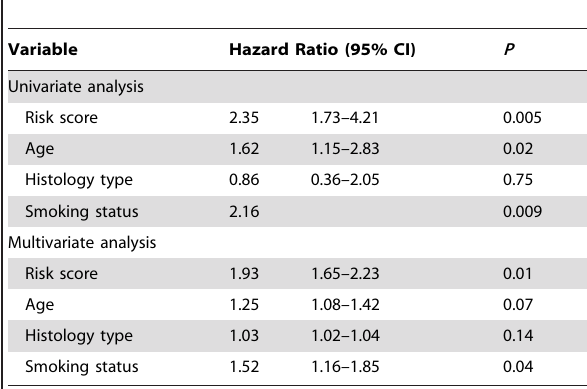
Table 5. Cox regression analysis of risk score and clinical characteristics in the entire patients